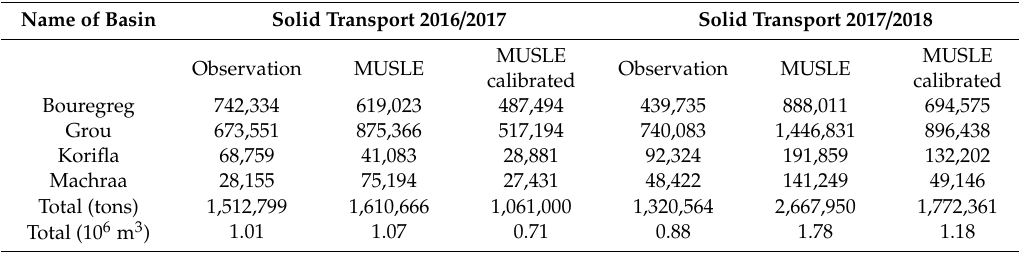
Table 19. Summary table of observation results, application of the MUSLE, calibrated MUSLE_ model and bathymetry for the four sub-basins of the Bouregreg.